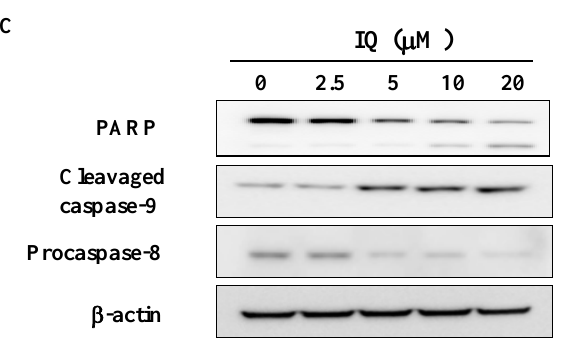
Figure 2. E ff ect of ilimaquinone (IQ) treatment on apoptosis. ( A ) The percentage of apoptotic cells (Q2 + Q4) after dimethyl sulfoxide (DMSO) vehicle, IQ, or 50 nM staurosporine (Stauro.) treatment for 48 h. SCC4 cells were treated with either DMSO, IQ, or Stauro. in 5% fetal bovine serum (FBS)-supplemented DMEM / F12 medium for 48 h and stained with propidium iodide (PI) / annexin V. Columns, mean; bars, S.D. ( n = 4). ** p < 0.01 vs. the control group. ( B ) Concentration-dependent e ff ect of IQ on caspase-3 activation. Staurosporine (Stauro.; 25 nM) was used as the positive control. Columns, mean; bars, S.D. ( n = 3). * p < 0.05 and ** p < 0.01 vs. the control group. ( C ) Expression of PARP, cleavage caspase-9, and procaspase-8 in SCC4 cells after 48 h treatment in 5% FBS-supplemented DMEM / F12 medium.